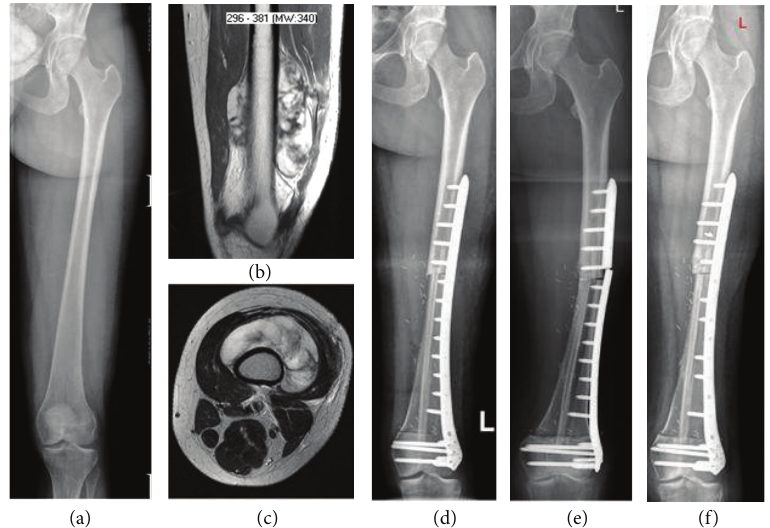
Figure 3: X-ray and MRI imaging in a 31-year-old female patient with Liposarcoma grade 2 of the left femur: before operation (a)-(b), one week after operation (c), plate breakage and fracture 15 months after operation (d), and one month after revision (e).